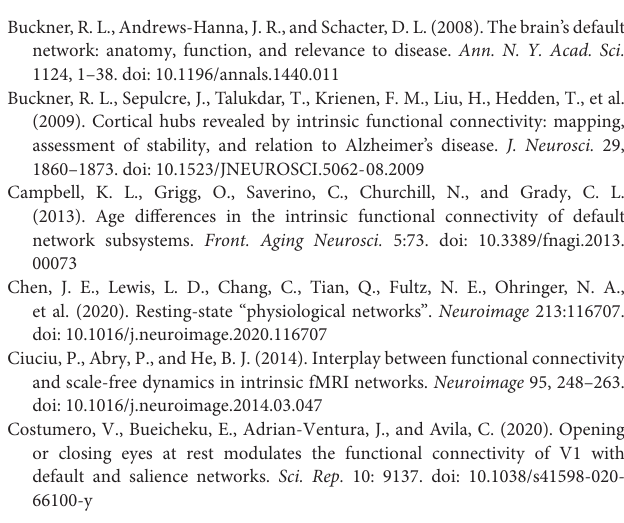
Supplementary Figure 1 | Anatomic locations for 4 different seed voxels of different tissue types including white matter (WM), cerebral spinal fluid (CSF), PCC, and motor cortex (MC). The crossing green lines depict the locations of the cross sections. Supplementary Figure 2 | The average CC histograms of the cohort for the 4 different seed voxels shown in Supplementary Figure 1 and Supplementary Table 1 . Supplementary Figure 3 | The convolutions of the CC histograms shown in Supplementary Figure 2 for the 4 different seed voxels located in WM (a), PCC (b), CSF (c), and MC (d). Supplementary Table 1 | The MNI coordinates for the 4 voxels of different tissue types illustrated in Supplementary Figure 1